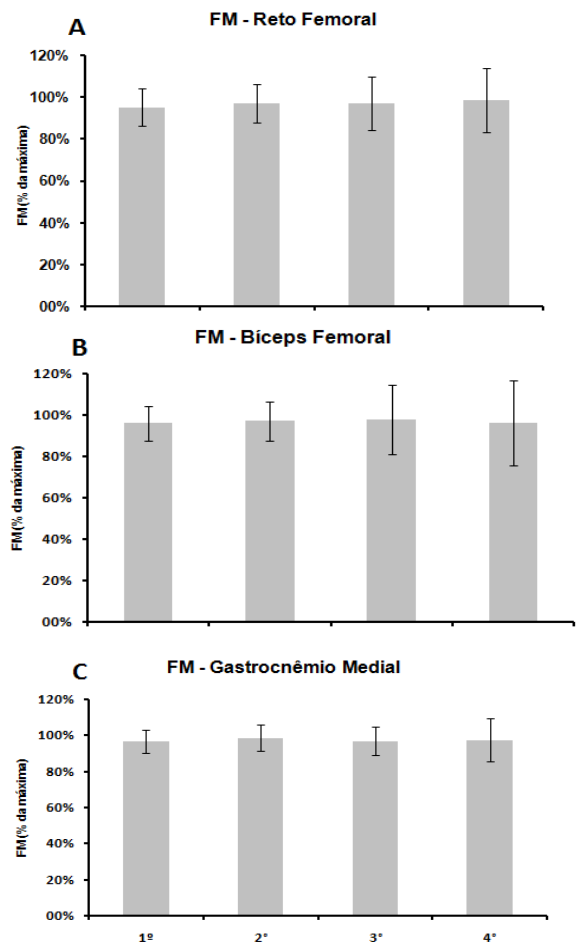
Figura 5- Valores em FM normalizados dos músculos avaliados durante o protocolo de resistência de saltos verticais: A ) Reto Femoral; B ) Bíceps Femoral; C ) Gastrocnêmio